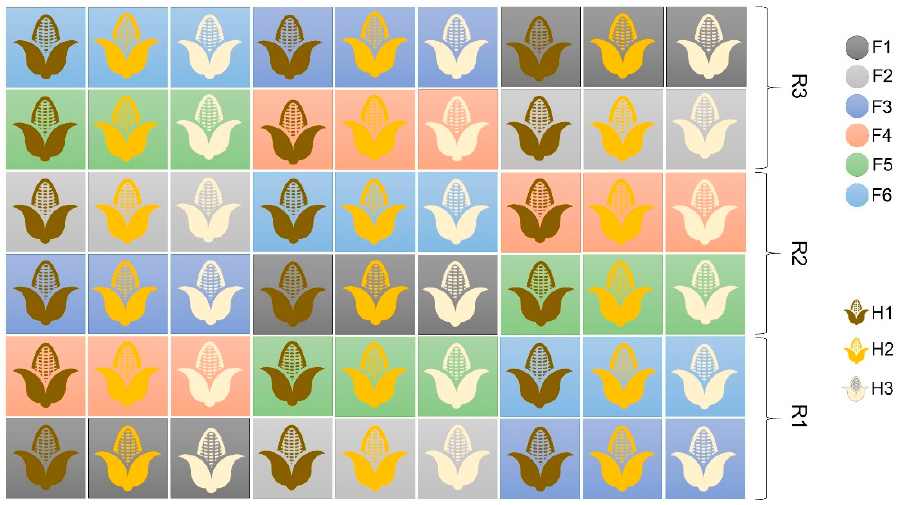
Figure 2. Planting plan of experimental maize crop at ARDS Turda (2018–2020), where “F1–F6” indicates fertilization gradient, “H1–H3” the three maize hybrids tested, “R1–R3” the repetitions.